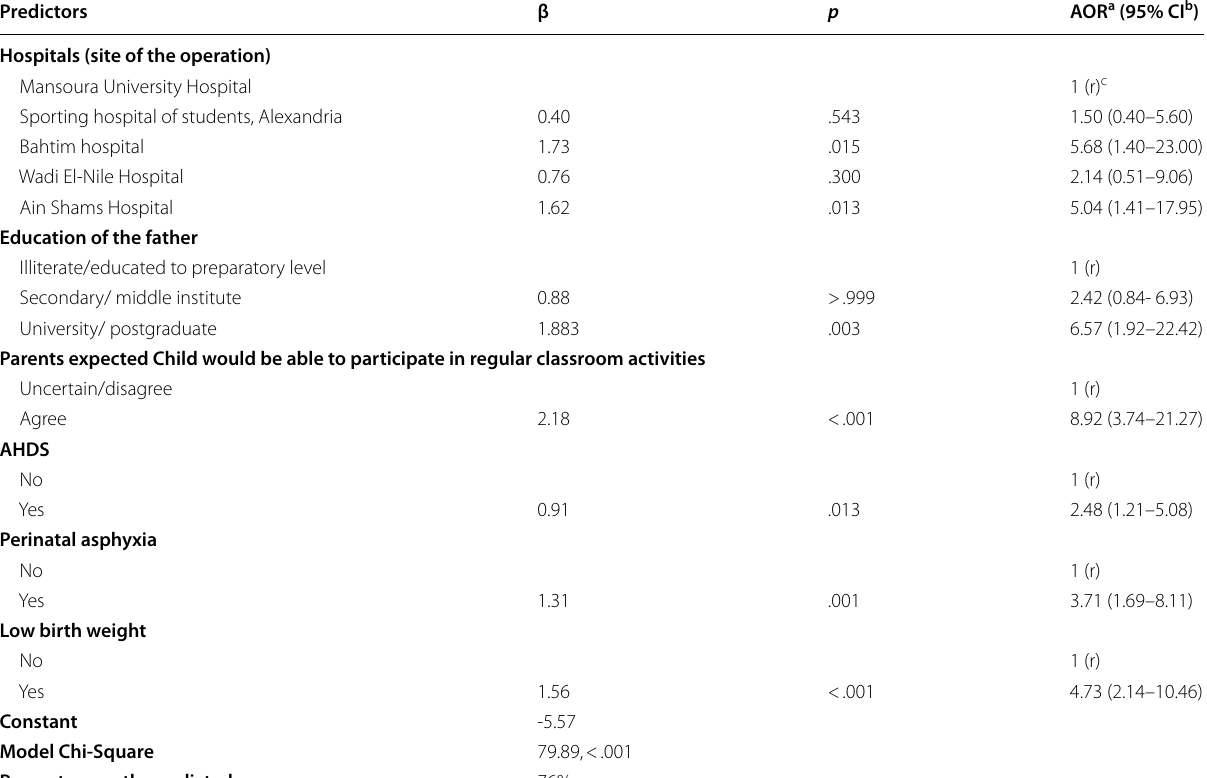
Table 4 Multivariate Logistic Regression of predictors of good outcome of cochlear implantation among children with moderate/ severe hearing loss, Egypt,